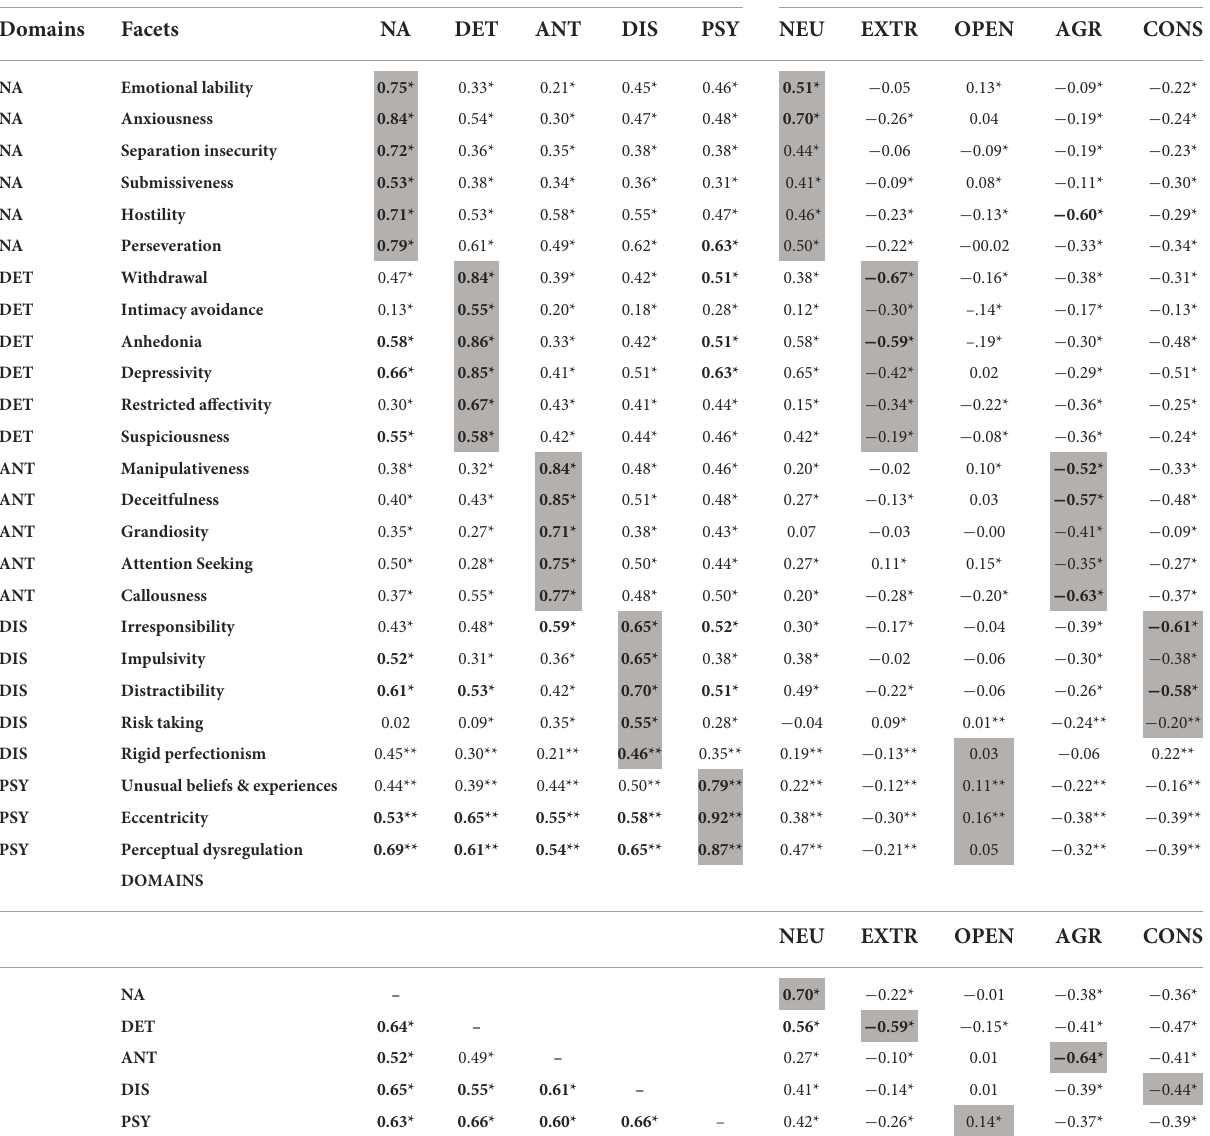
TABLE 2 PID-5 (paper-and-pencil) convergent validity indicators using NEO-FFI as reference ( N = 730). PID-5 domains NEO-FFI domains Domains Facets